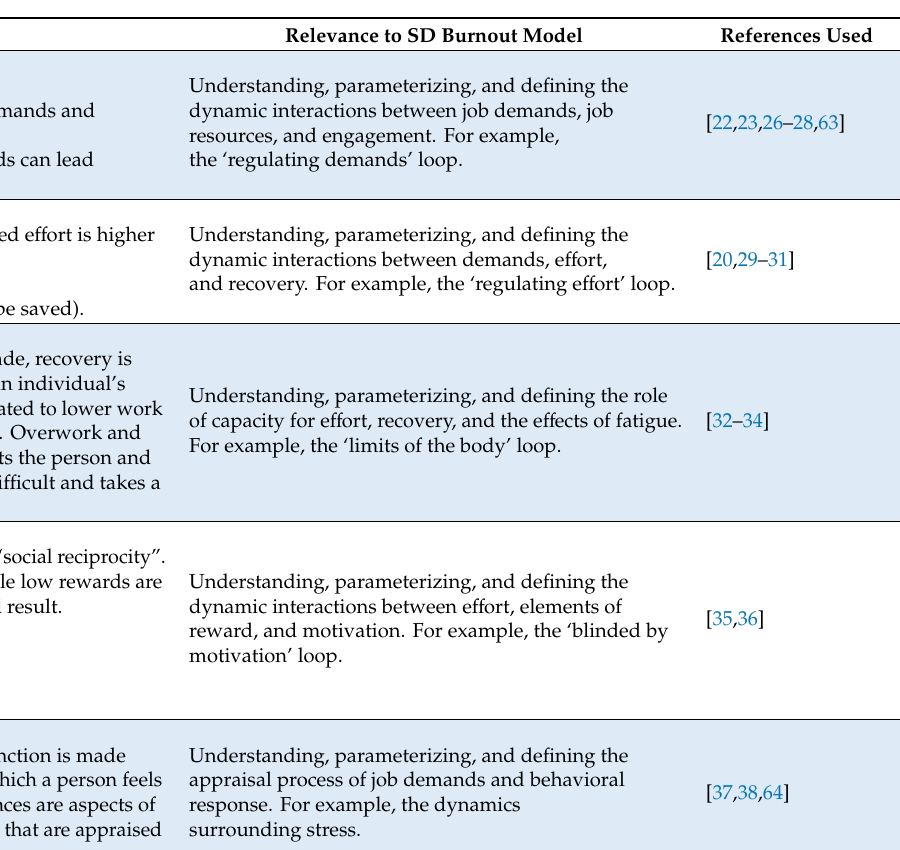
Table 1. The existing theoretical models included in the system dynamics (SD) burnout model, their relevance to the SD model, and